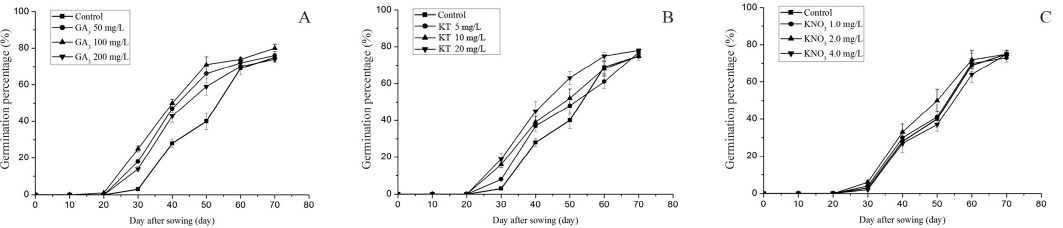
Figure 3. Effect of plant growth regulators on the seed germination of Tulipa thianschanica . ( A ) GA 3 (Gibberellin); ( B ) KT (Kinetin); ( C ) KNO 3.